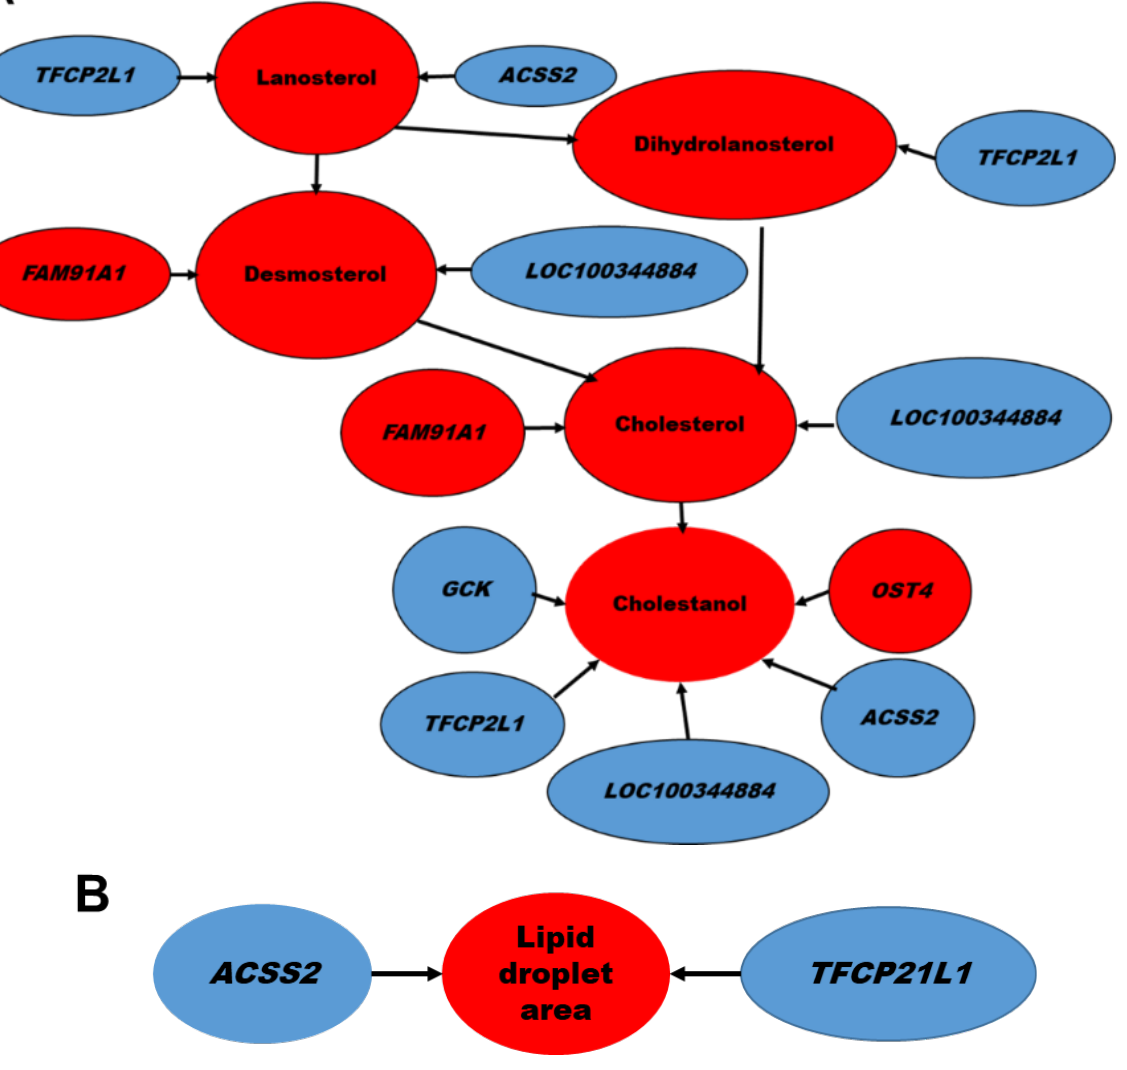
Figure 7. Correlation between hepatic transcripts and biological parameters in response to squalene intake. ( A ) transcripts associated with sterol precursors in the Kandutsch–Russell pathway. ( B ) transcripts related to lipid droplet area. Red; up regulation. Blue; down regulation. Significant ( p < 0.02) Spearman’s correlations are shown.